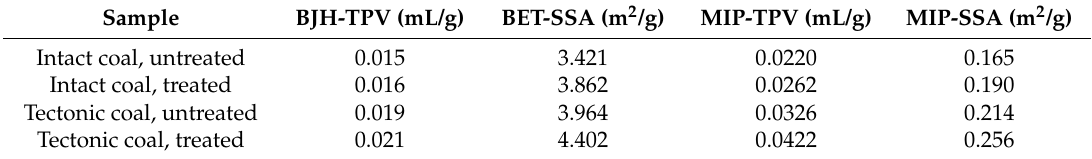
Table 3. Total pore volumes and specific surface areas for untreated and ScCO 2 -treated intact and tectonic coal samples.